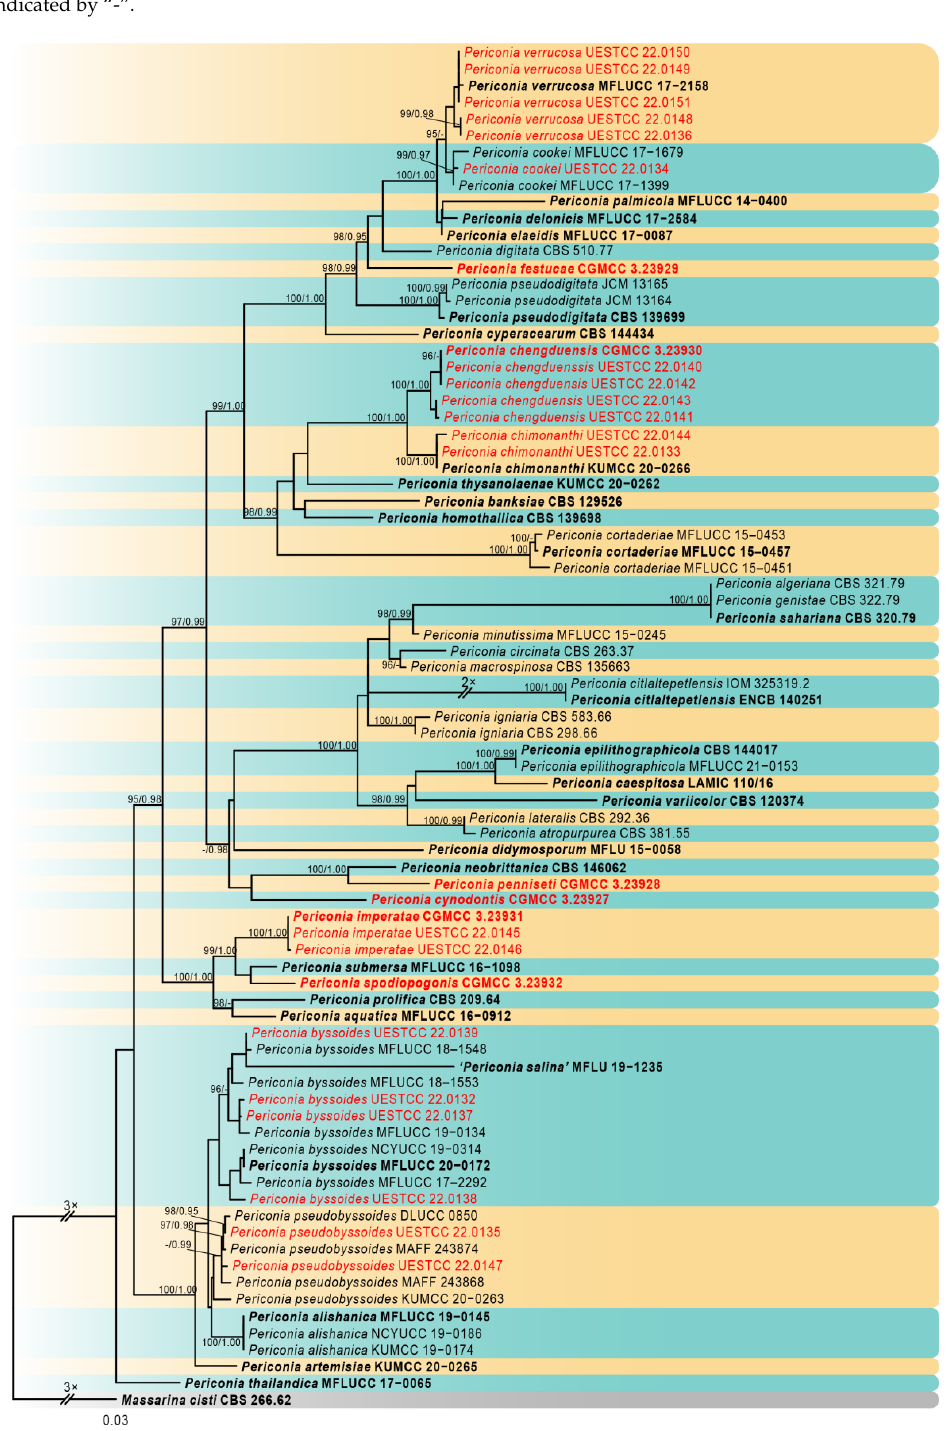
Figure 1. Phylogram of the best-scoring ML consensus tree based on a combined dataset (SSU, ITS, LSU, TEF1, and RPB2 ) of Periconia . Novel isolates are indicated in red. Isolates from type materials are in bold. The ML ultrafast bootstrap values/Bayesian PP greater than 95%/0.95 are shown at the respective nodes. The tree is rooted with Massarina cisti CBS 266.62 (Massarinaceae, Pleosporales).